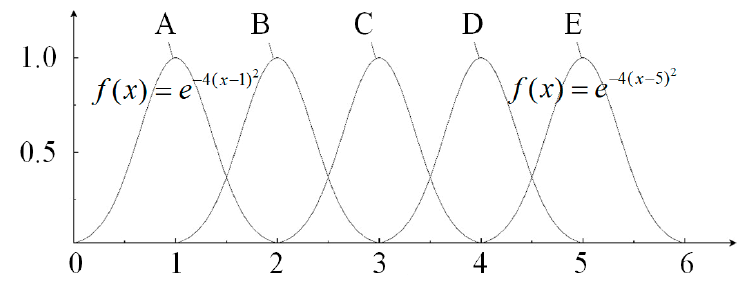
Figure 13. Membership function in the fuzzy mapping.